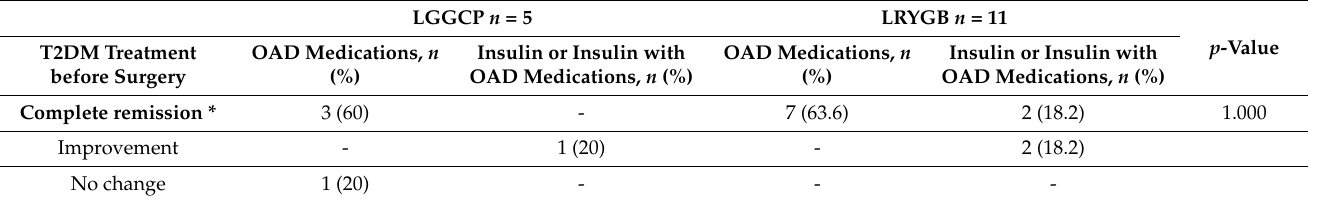
Table 4. Diabetes mellitus remission and improvement 3 year after the operation according to the T2DM treatment before